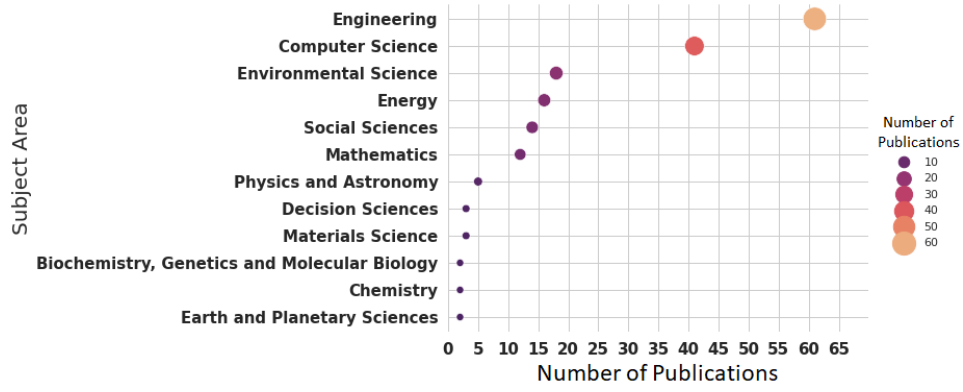
Figure 5. Publications on indoor occupancy by subject